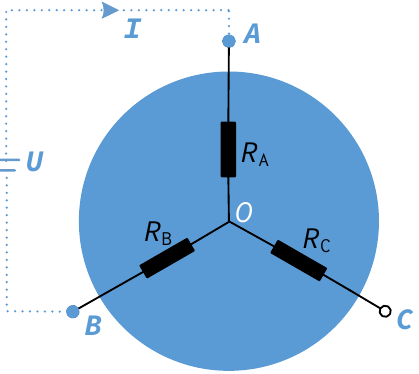
Figure 1. Equivalent circuit when a DC voltage is excited to phase A and B of a healthy motor.